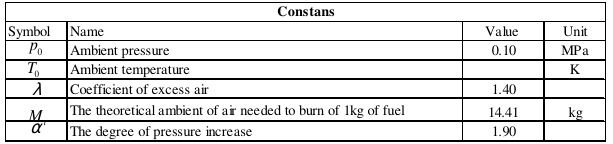
Table 2. Constants and their values